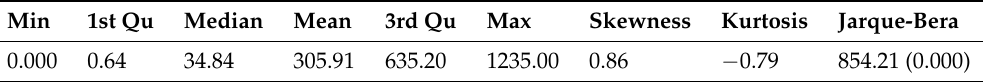
Table 1. Summary statistics of the GHI (average W/m 2